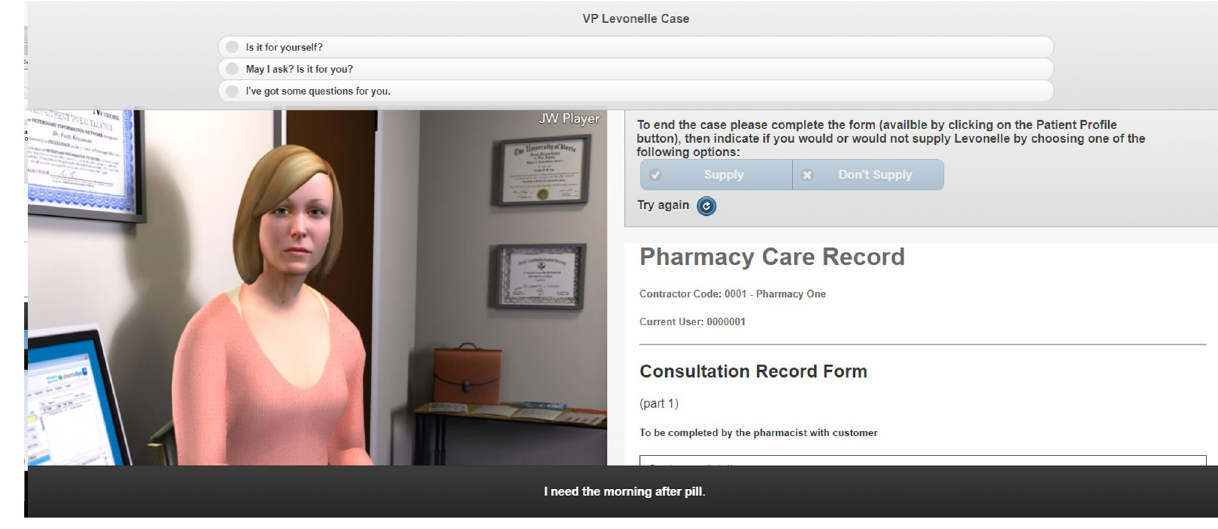
Fig 1. Screenshot of the EHC VP simulation.